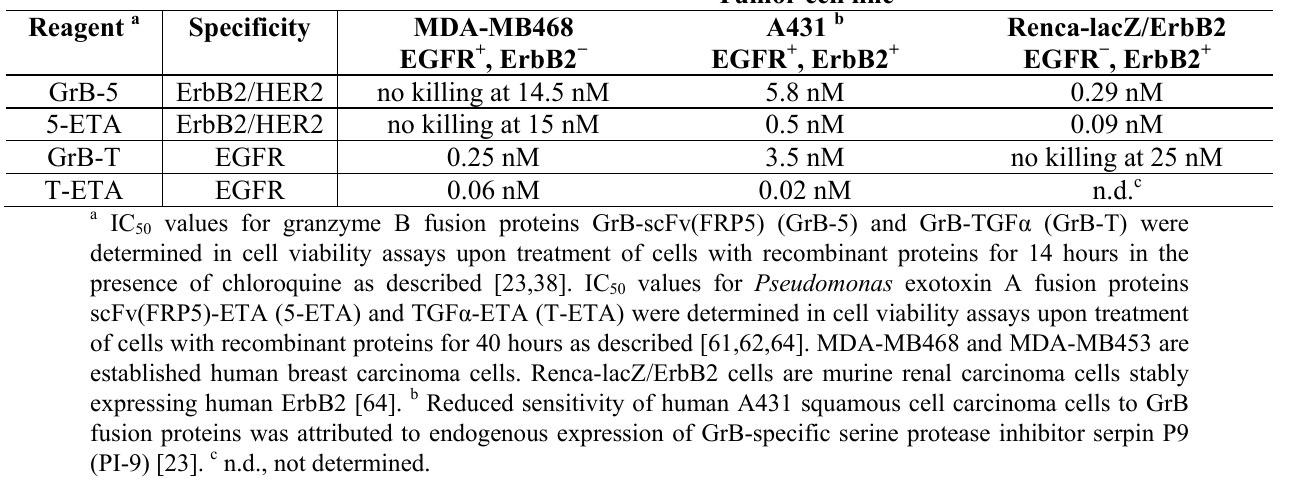
Table 1. Specificity and cytotoxicity of GrB fusion proteins and recombinant toxins. Reagent